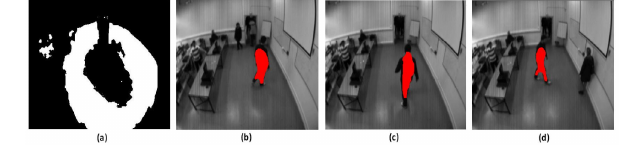
Figure 8. (a). Scene Occupation Model (b).(c).(d). Abnormal events